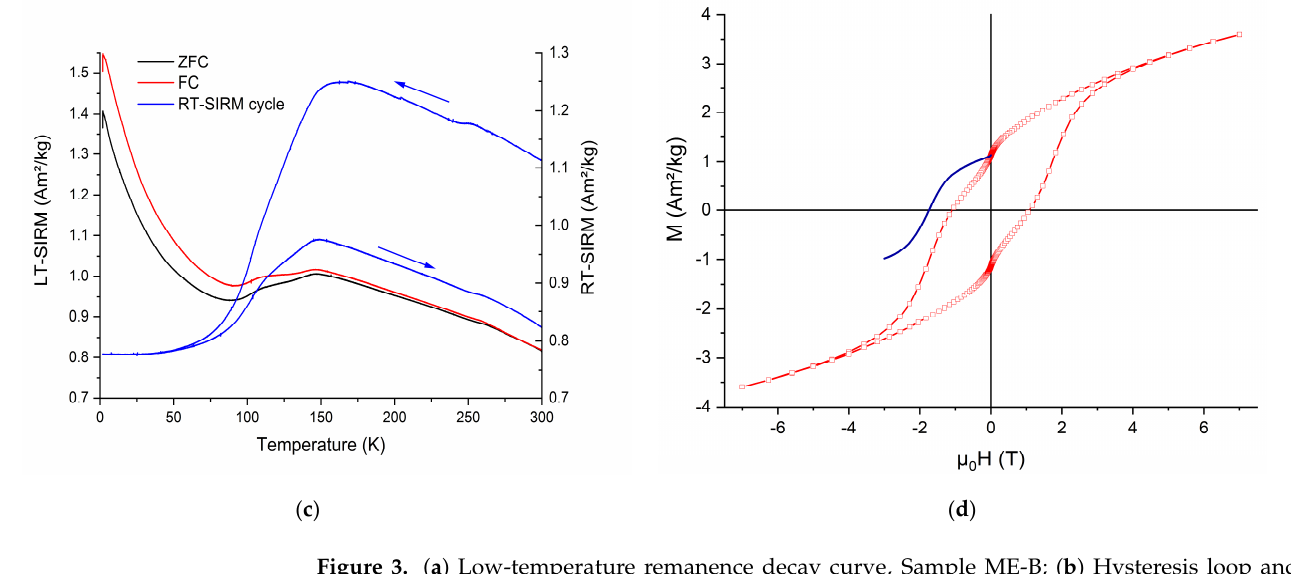
Figure 3. ( a ) Low-temperature remanence decay curve, Sample ME-B; ( b ) Hysteresis loop and backfield demagnetization curve measured at 295 K, Sample ME-B; ( c ) Low-temperature remanence decay curve, Sample SUP-2; ( d ) Hysteresis loop and backfield demagnetization curve measured at 295 K, Sample SUP-2. Table 4. Coercivity, magnetization, and remanence of synthesized